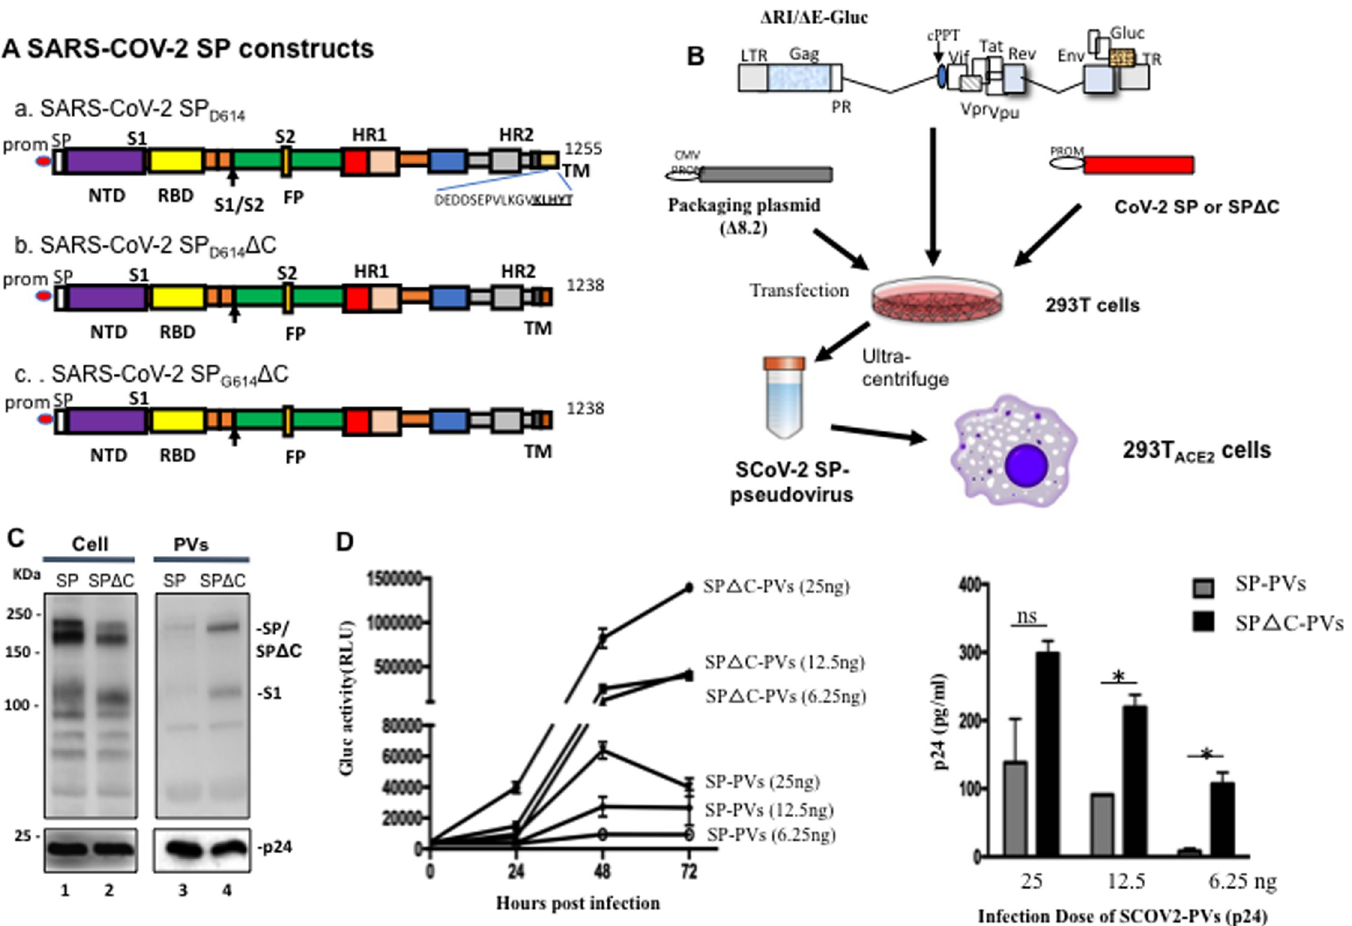
Fig 1. Generation of SARS-CoV2-SP-pseudotyped lentivirus particles (SCoV-2-SP-PVs). A) Schematic representation of SARS-CoV-2SP, SARS-CoV-2SP Δ C, and SARS-CoV-2SP G614 Δ C expressing plasmids. B) Schematic representation of plasmids and procedures for production of SARS-CoV2-SP-pseudotyped lentivirus particles (SCoV-2-SP-PVs). C) Detection of SARS-CoV-2 SPs and HIV p24 protein expression in transfected 293T cells and viral particles by WB with anti-SP or anti-p24 antibodies. D) Different amounts of SCoV-2-SP-PVs and SCoV-2-SP Δ C-PVs virions (adjusted by p24) were used to infect 293T ACE2 cells. At different time intervals, the Gaussia Luciferase activity (Gluc) (left panel) and PVs-associated p24 (at 72 hrs) in supernatants was measured. Statistical significance was determined using unpaired t- test, and significant p values are represented with asterisks, � �